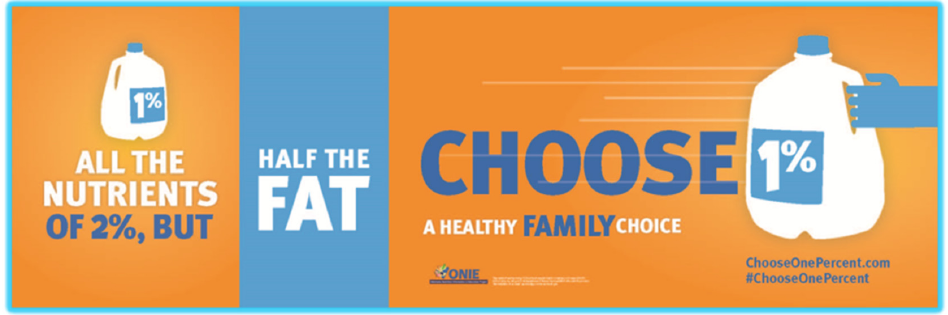
Figure 2. Choose 1% Milk Social Media Infographic.